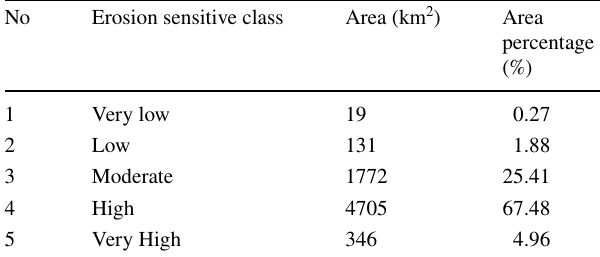
Table 9 Relationship between soil erosion and land cover Erosion/land use Very low